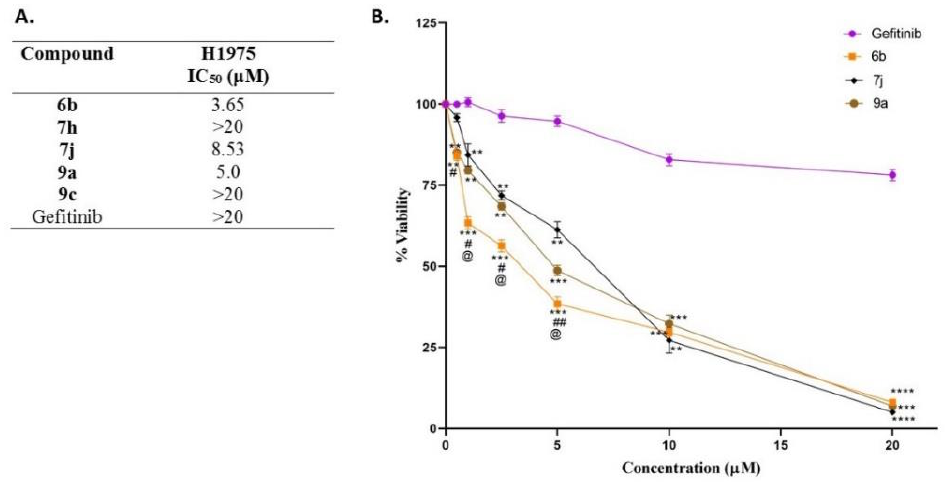
Figure 4. ( A ) IC 50 values of EGFR inhibitors against non-small cell lung cancer (NSCLC) cell line H1975 carrying L858R + T790M double mutation ( B ). Dose–response curve for 6b , 7j and 9a in comparison with gefitinib control. The percentage of viable cells is shown relative to that of untreated control cells. For statistical analysis of the data, GraphPad Prism 8.0.2 software (San Diego, CA, USA) was used. Data were presented as means ± standard error mean (S.E.M.) of three independent experiments. Two-way ANOVA was used for the comparison of multiple groups. Statistical significance was checked at * or # or @ p < 0.05, ** or ## p < 0.01, *** p < 0.001, **** p < 0.0001, where * represents difference vs. control group, # represents difference vs. compound 7j and @ represents difference vs. 9a .